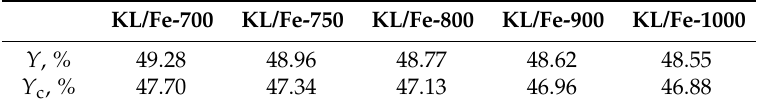
Table 1. Thermal treatment yields ( Y , %) and carbon yields ( Y c , %) of kraft lignin (KL)/Fe-X